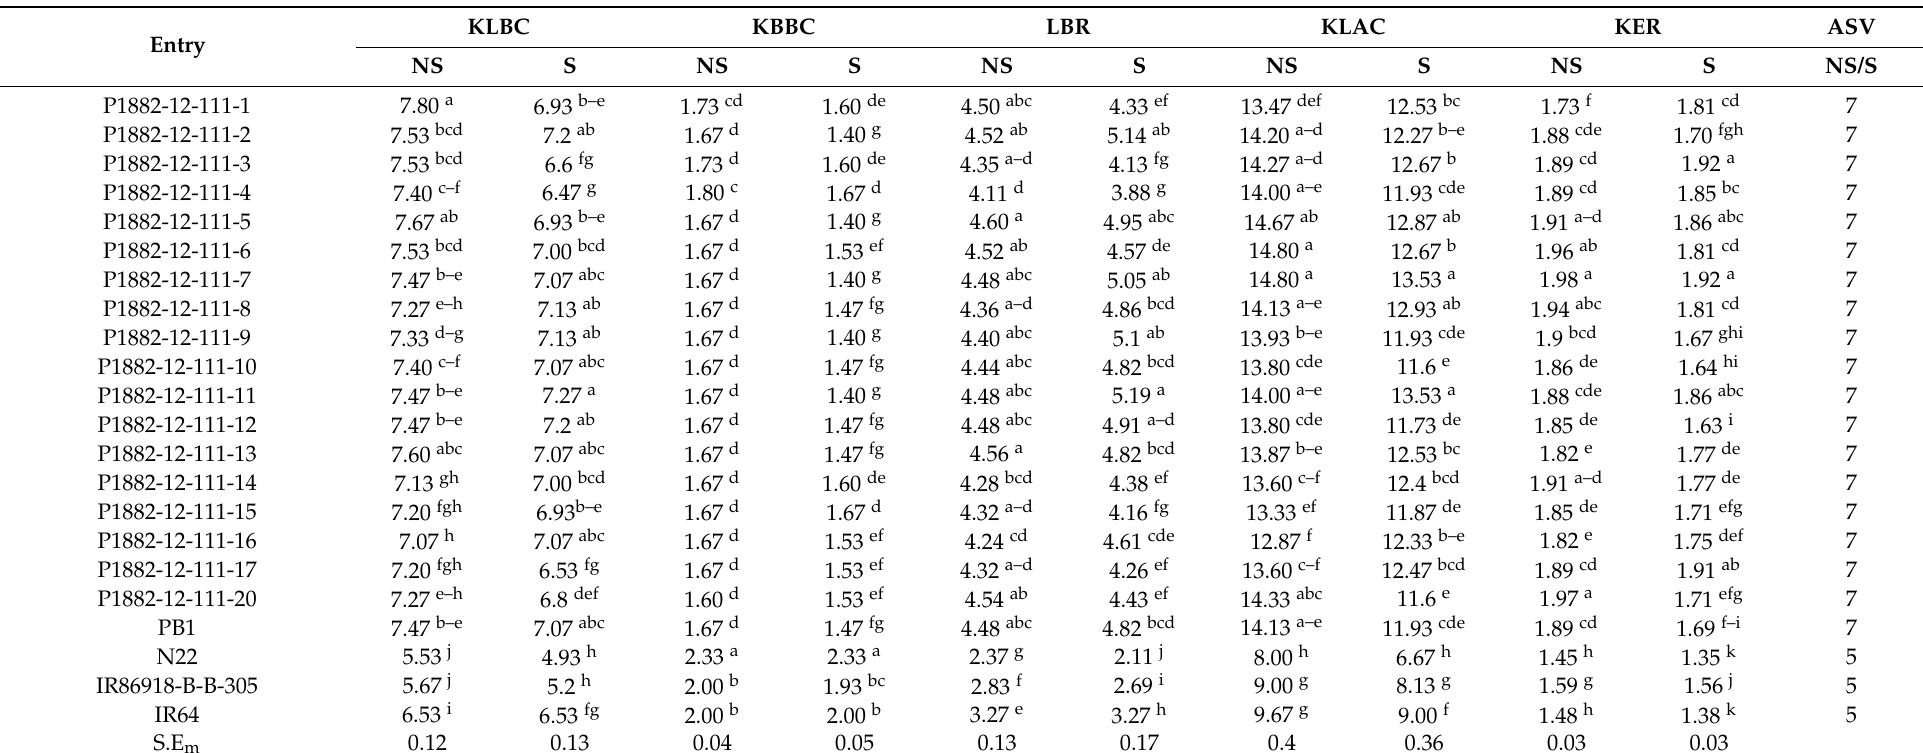
Table 7. Grain and cooking quality traits of the NILs and the recurrent parent, PB1 along with checks during Kharif 2019 under stressed (S) and unstressed (NS)